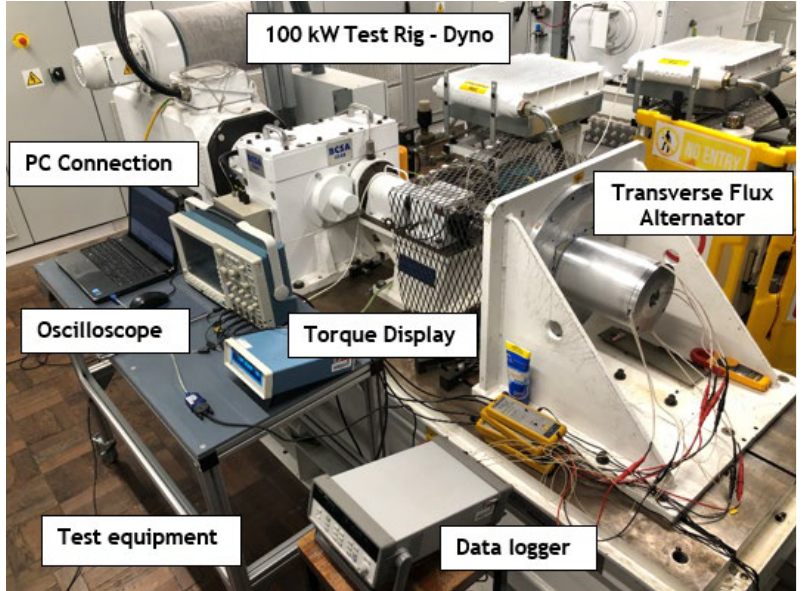
Figure 11. The prototype transverse flux alternator mounted on 100 kW drive motor for dynamic, electrical tests.